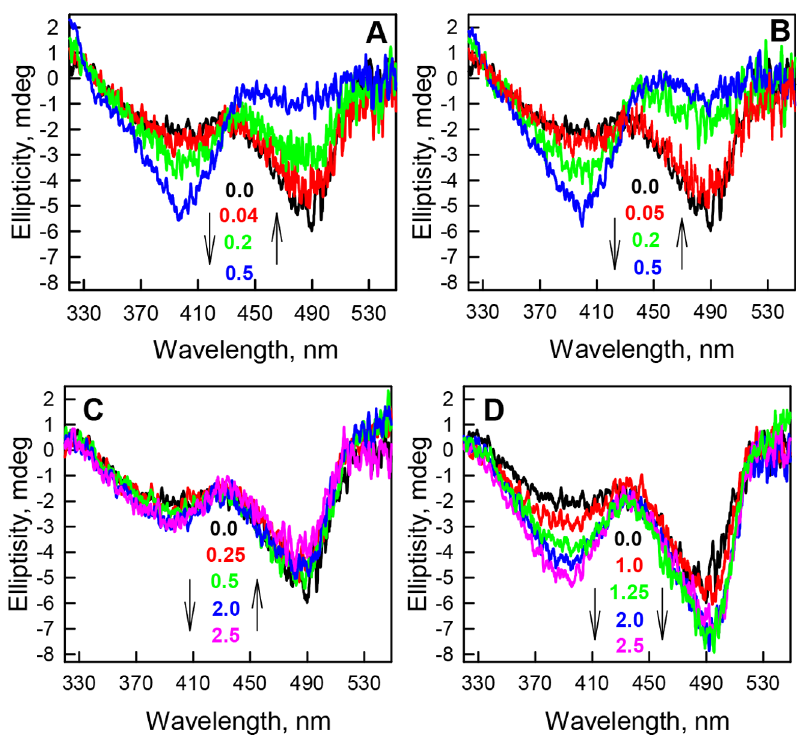
Figure 3. The effect of ionic denaturants and salts on the CD in the visible range of sfGFP. ( A ) CD spectra of sfGFP in the visible-UV region were recorded at final GTC concentrations of 0.0 (black line), 0.04 (red line), 0.2 (green line), and 0.5 M (blue line). ( B ) CD spectra of sfGFP in the visible-UV region were recorded at final NaSCN concentrations of 0.0 (black line), 0.05 (red line), 0.2 (green line), and 0.5 M (blue line). ( C ) CD spectra of sfGFP in the visible-UV region were recorded at final GdnHCl concentrations of 0.0 (black line), 0.25 (red line), 0.5 (green line), 2.0 M (blue line) and 2.5 M (pink line). ( D ) CD spectra of sfGFP in the visible-UV region were recorded at final NaCl concentrations of 0.0 (black line), 1.0 (red line), 1.25 (green line), 2.0 M (blue line) and 2.5 M (pink